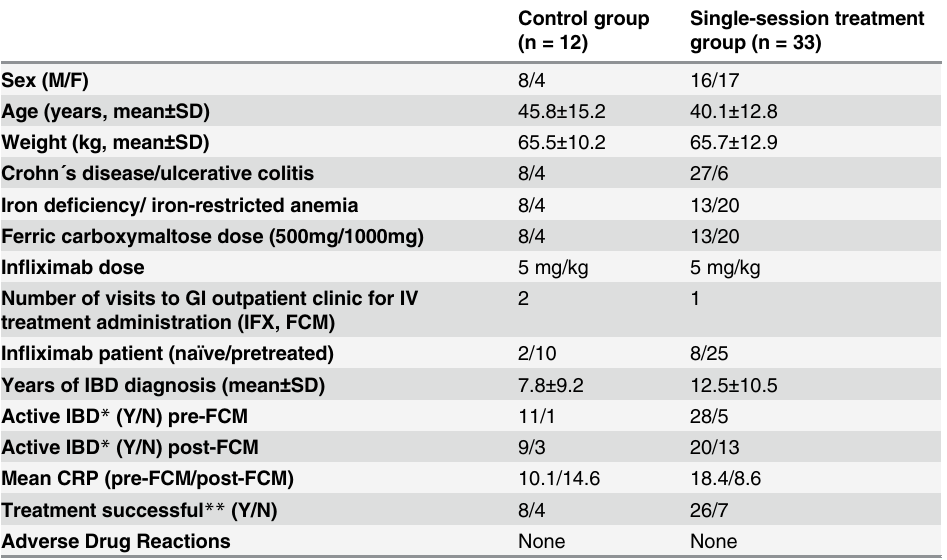
Table 1. Demographic and clinical characteristics of IBD patients in the control group and the single- session treatment